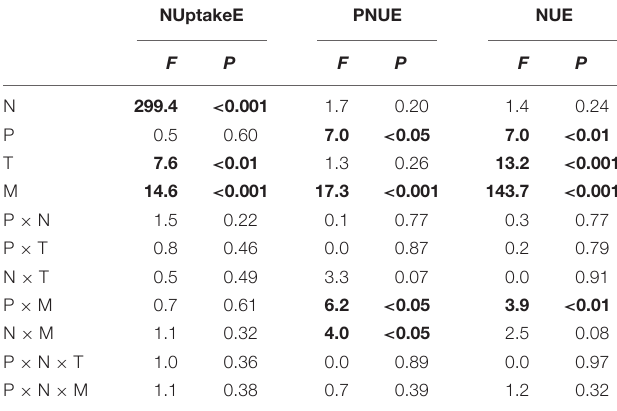
TABLE 2 | Four-factorial ANOVAs (type III SS) on the effects of N availability (N), P availability (P), temperature (T), soil moisture (M), and their interactions on the variance of N uptake efficiency (NUptakeE), photosynthetic N use efficiency (PNUE), and N use efficiency (NUE) of European beech saplings grown at increasing soil N:P ratios and climate